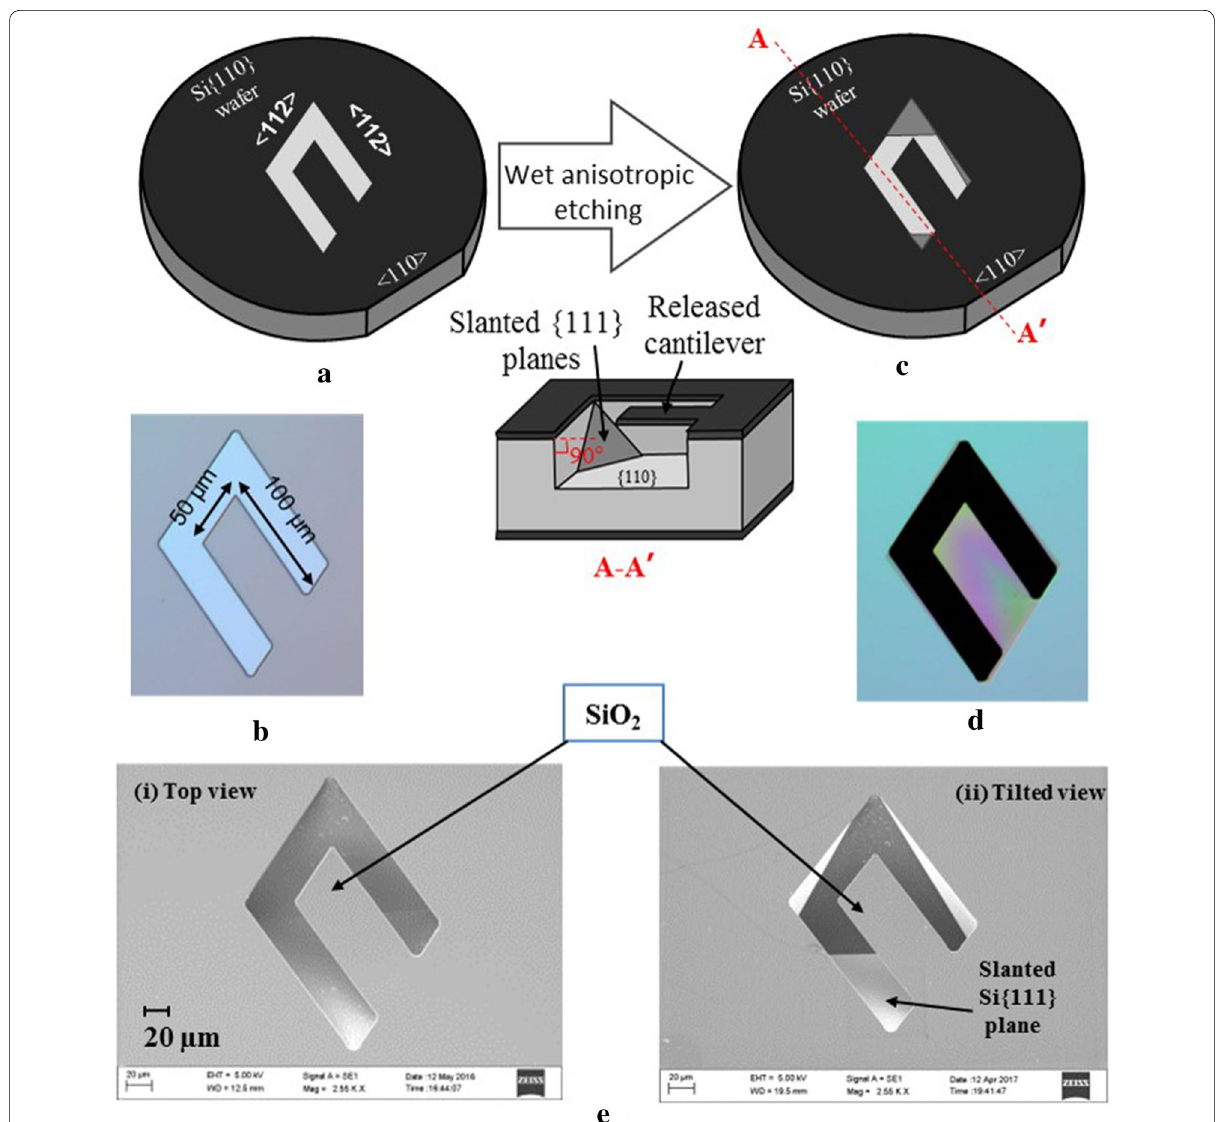
Fig. 7 Silicon dioxide cantilever beam fabricated in NH 2 OH-added KOH solution: a patterning of oxide layer using photolithography and oxide etching, b optical image of cantilever beam patterned in oxide layer, c wet anisotropic etching to release the beam, d optical and e SEM images of released